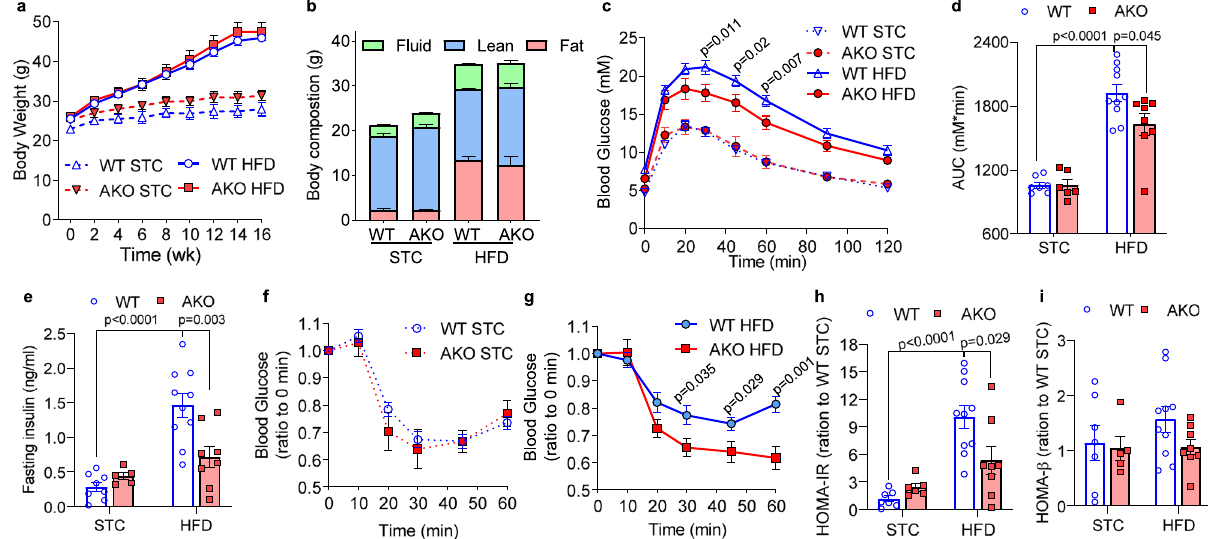
Fig. 2 | Adipocyte-speci fi c deletion of Ldha protects against glucose intoler- ance and insulin resistance in obese mice. Wildtype (WT)and adipocyte-speci fi c Ldha knockout (AKO) mice were fed with standard chow (STC) or high fat diet (HFD)for4months. a Bodyweightofthemice.WT-STC: n =6;WT-HFD: n =5;AKO- STC: n =7; AKO-HFD: n =9 biologically independent animals. b Body composition of the mice at the end of the treatment. STC-WT: n =6; STC-AKO: n =5; HFD-WT: n =7; HFD-AKO: n =5 biologically independent animals. c Glucose tolerance test (GTT)and d Areaunderthecurve(AUC)oftheGTT.STC-WT: n =7;STC-AKO: n